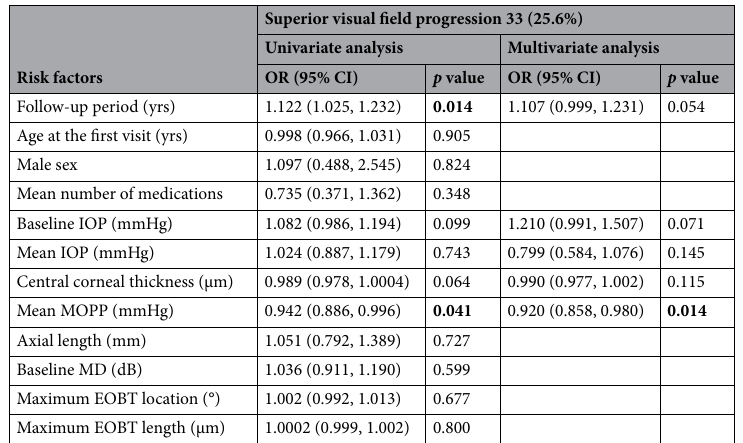
Table 4. Risk factors associated with visual field progression in the superior hemifield. CI confidence interval, EOBT externally oblique border tissue, IOP intraocular pressure, MD mean deviation, MOPP mean ocular perfusion pressure. The best multiple logistic regression model was chosen based on the Akaike Information Criterion. Factors with statistical significance are marked in bold.